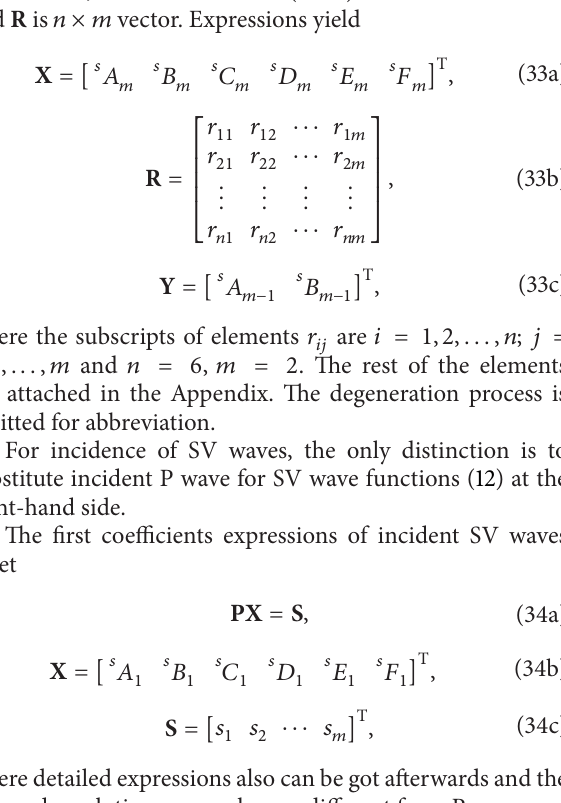
Similarly, the elastic boundary conditions of 𝑚 th ( 𝑚 ≥ 2